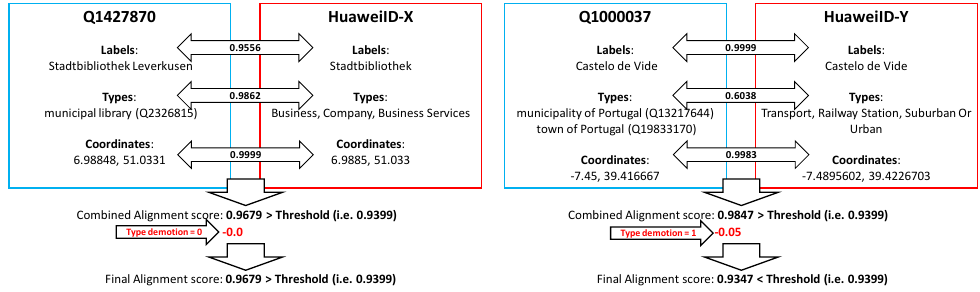
Figure 6. Examples of matching ( left ) and non-matching ( right ) POIs’ pairs as obtained from running